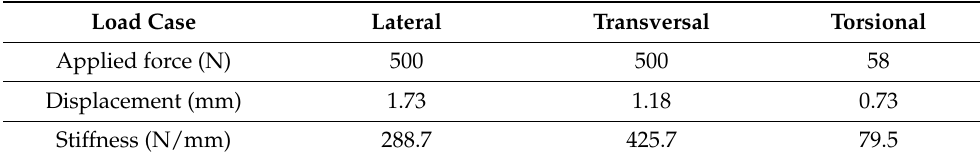
Table 3. Measured stiffness of the composite hood “A”.